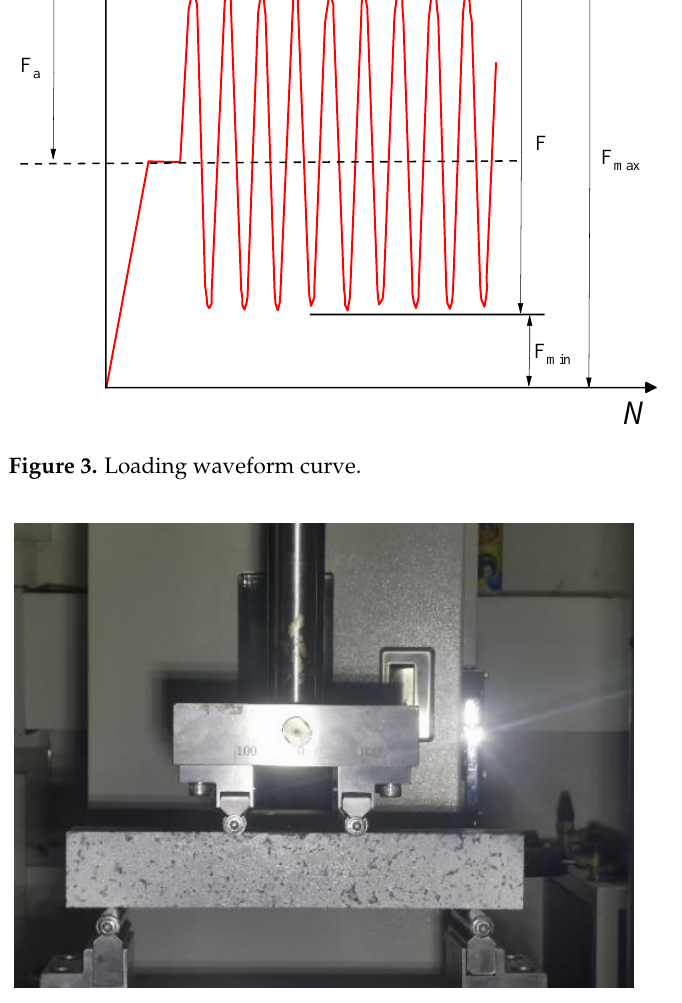
Figure 4. Specimen loading method.